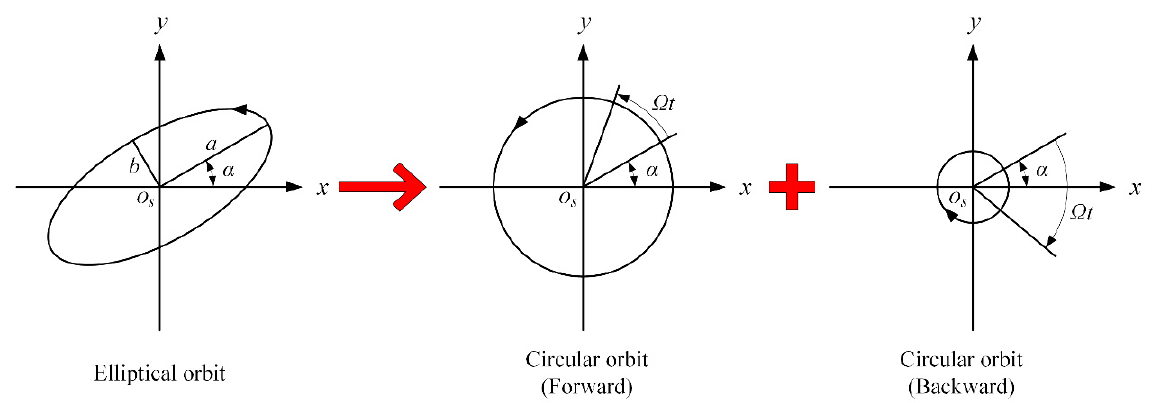
Figure 4. Elliptical Orbit Decomposition.